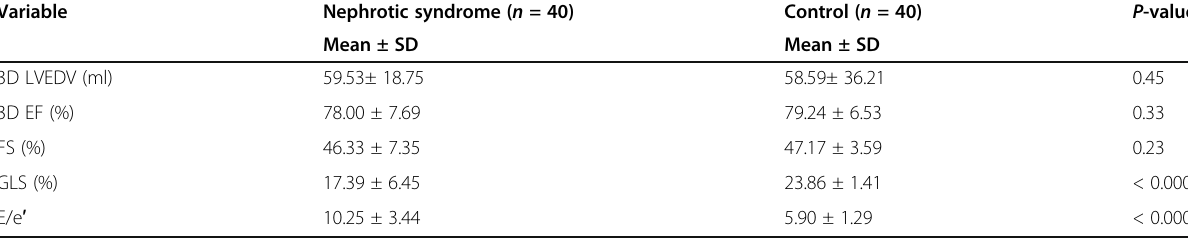
Table 2 Left ventricular echocardiographic parameters in cases vs. controls Variable